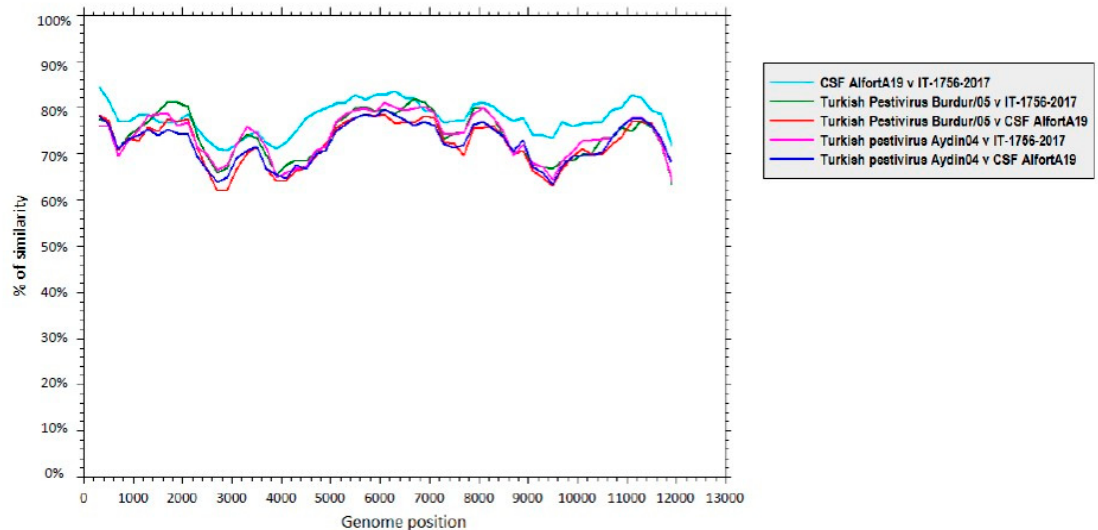
Figure 3. Sequence identity between the complete genome of Ovine/IT/1756/2017 and the closely related pestiviruses, i.e., classical swine fever virus(CSFV; strain Alfort/187, GenBank accession no. X87939) and Aydin-like pestiviruses (strain Aydin/04,GenBank accession no. JX428945 and Burdur/05, GenBank accession no. KM408491). Similarity plots were generated using SSE version 1.2, using a sliding window of 600 and a step size of 200 nucleotides.